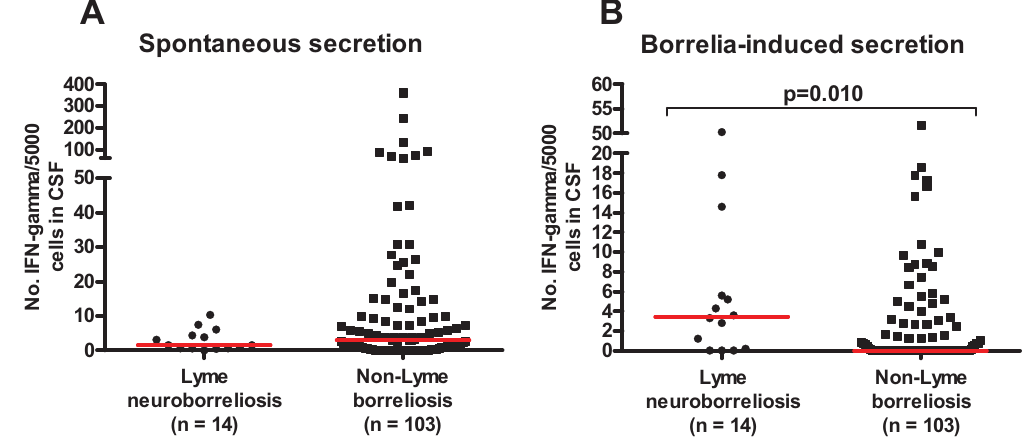
Figure 1. Spontaneous ( A ) and Borrelia -induced IFN-(cid:2) secretion ( B ) in cerebrospinal fluid from patients with Lyme neuroborreliosis and non-Lyme borreliosis. Medians are shown. The P-value represents the difference between the groups when compared using a Mann-Whitney